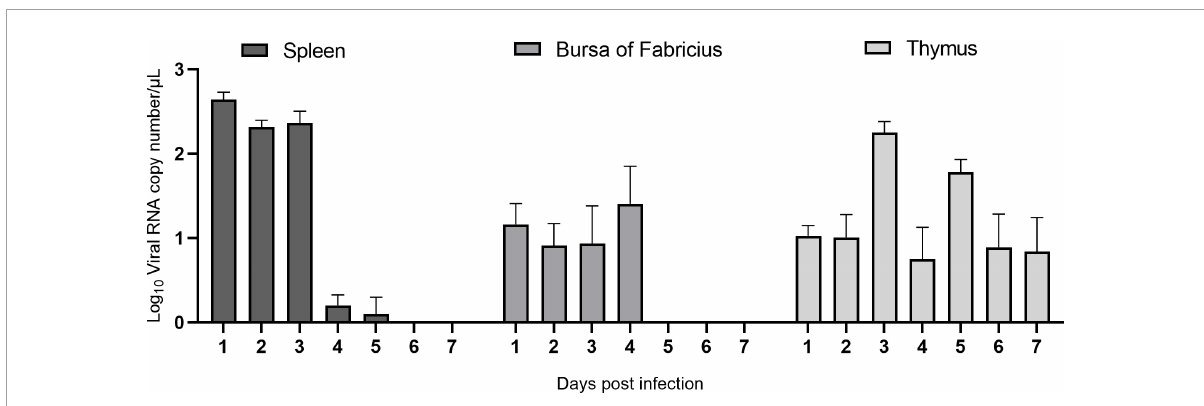
FIGURE3 The ARV copy number in the spleen, bursa of Fabricius, and thymus in ARV-infected SPF chickens. ARV strain S1133 (10 4 TCID 50 /0.1 ml) was used to infect chickens through the footpad. At 1, 2, 3, 4, 5, 6, 7, 10, 14, 21, 28, and 35 days postinfection (dpi), three chickens were randomly collected from each group, and the ARV viral load was measured by real-time quantitative PCR. The data are the mean ± SD of three independent experiments.